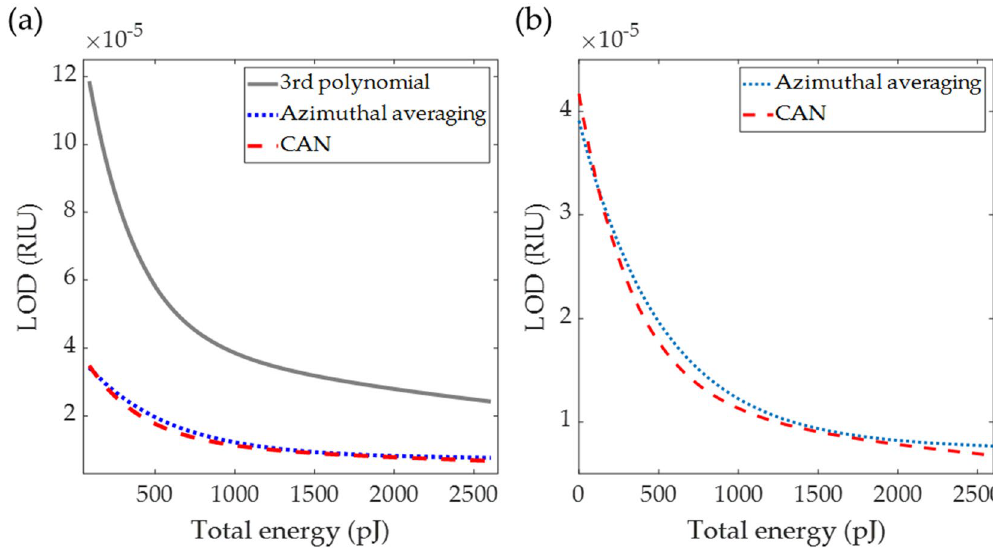
Figure 13. Shows ( a ) detection limits (LOD) in RIU for the three measurement techniques for different incident light energy levels from 90 to 2600 pJ computed for the sample refractive index n s of 1.33, ( b ) zoomed-in figure of ( a ) to compare the CAN method and the azimuthal angle averaging